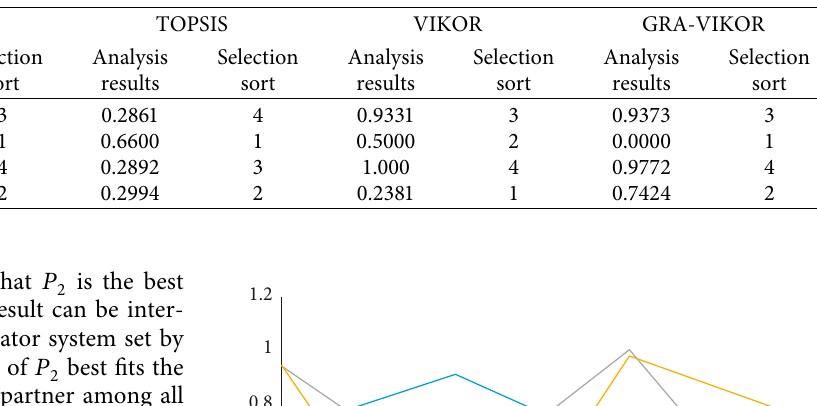
Table 8: Comparative analysis of the methods.